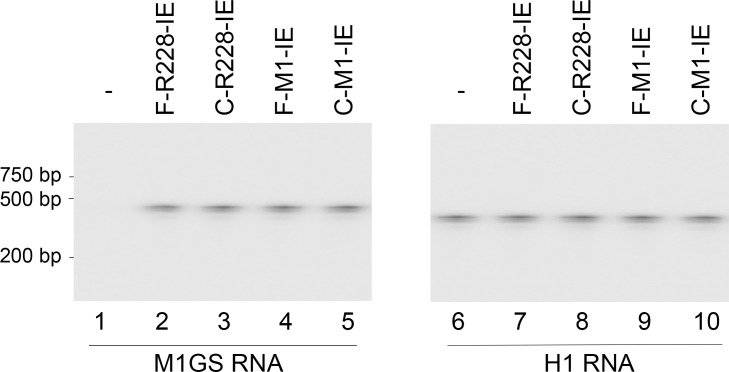
Ribozyme expression in cells assayed using Northern blot analysis.RNA fractions (40 μg) from the parental U251 cells (-) and cells expressing different ribozymes (F-M1-IE, C-M1-IE, F-R228-IE, and C-R228-IE) were hybridized to probes for detection of human H1 RNA (internal control) (lanes 6–10) and ribozymes (lanes 1–5).